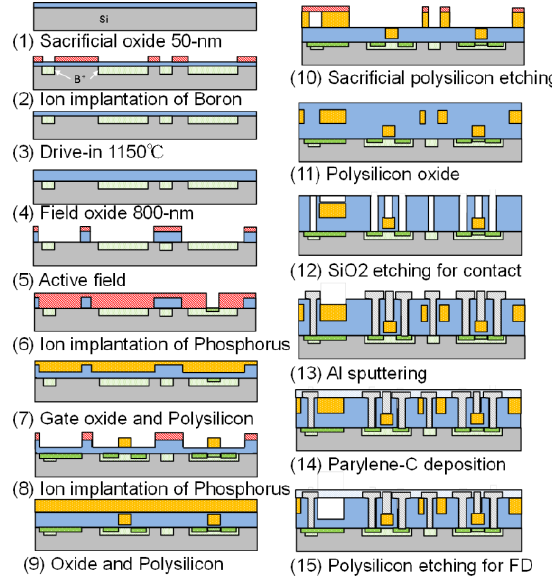
Figure 4. Fabrication process overview of the MEMS Fabry–Perot interferometer sensor with an integrated source follower circuit.